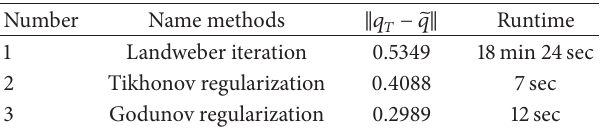
Table7:Comparativeanalysisofmethodsinthecaseofnoisewithin